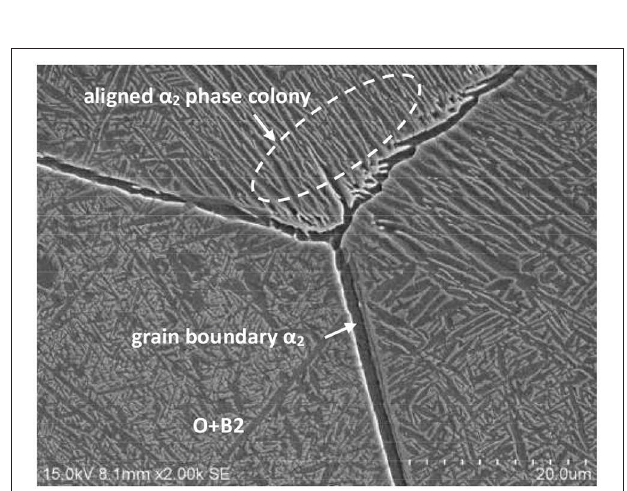
FIGURE 2 | Initial microstructure of the Ti-25.5Al-13.5Nb-2.8Mo-1.8Fe alloy for the hot compression